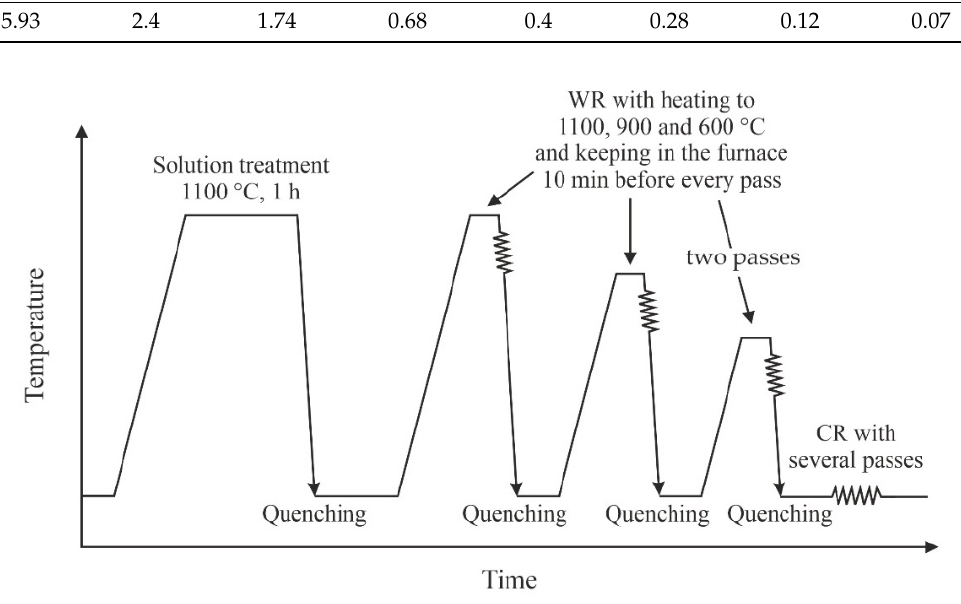
Table 1. Chemical composition of the austenitic reactor steel EK-164 (wt. %). Fe Ni Cr Mo Mn Si Ti Nb V C